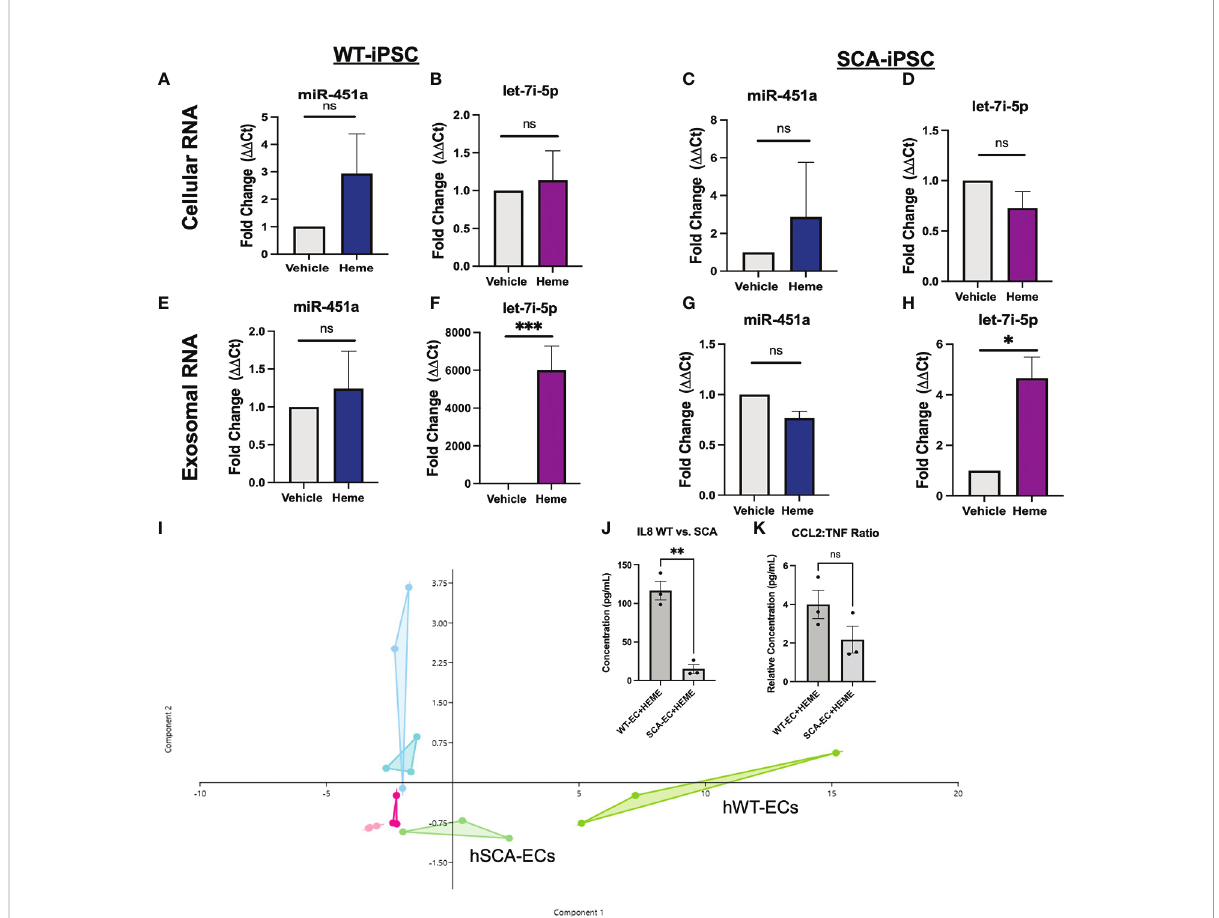
FIGURE 2 Molecular Effects of Heme-Induced In fl ammation on Endothelial Cells (A – D) RT-qPCR of total lysate mRNA expression of miR-451a and let-7i- 5p in respective hiPSC-ECs treated with either DMSO vehicle of 30 m M or Heme for 24 hrs. Paired t-test was performed for statistical analysis (n=3) (E – H) RT-qPCR of exosomal mir-451a and let-7i-5p expression in respective hiPSC-ECs treated with either DMSO vehicle or 30 m M Heme for 24 hrs. Paired-t test was performed for statistical analysis. Paired t-test was performed for statistical analysis (I) . Overlapping Principal Component Analysis of cytokine in fl ammatory pro fi le (representing 26 cytokines) of hiPSC-ECs treated with DMSO vehicle, 30 m M Heme or untreated cells of either WT or SCA hemoglobin genotypes. Cytokine ratios were normalized to basic FGF value. The Aqua color represents the WT-EC groups. The dark pink represents the WT-EC-vehicle groups. The chartreuse fi gure represents the WT-EC and Heme treatment groups. The light blue represents the SCA-EC only groups. The light pink represents the SCA-EC-vehicle group. The light green represents the SCA-EC- Heme treatment groups (hSCA-ECs). The component 1 and component 2 eigenvalue and percent variance are 22.7 and 87.6% and 1.6 and 6.2%, respectively. (J) Comparison of absolution IL-8 concentration between WT-ECs and SCA-ECs treated with 30 m M Heme for 24 hrs. Un-paired t- test was performed for statistical analysis (n=3) (K) Comparison of CCL2:TNF-alpha cytokine ratio in WT-ECs and SCA-ECs treated with 30 m M of Heme for 24 hrs (n=3). Unpaired t-test was performed for statistical analysis. ns indicates no signi fi cant difference, * indicates p < 0.05, ** indicates p < 0.01, *** indicates p < 0.001 for all bar